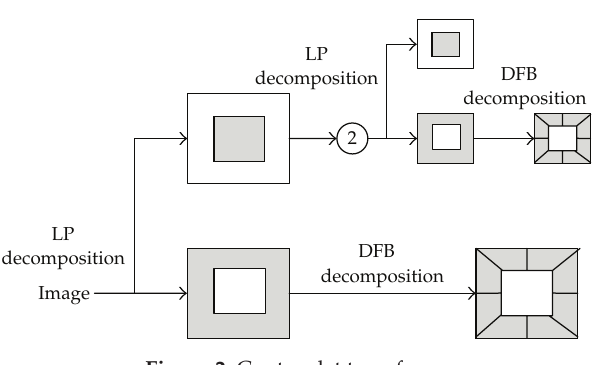
Figure 2: Contourlet